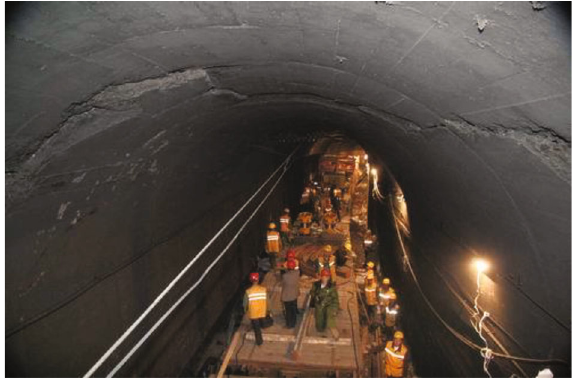
Figure 1: Cracking of tunnel